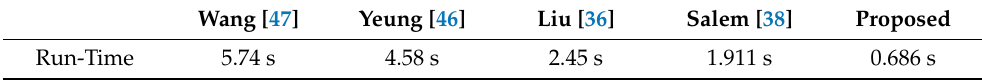
Table 5. Average run-time to reconstruct 7 × 7 out of 3 × 3